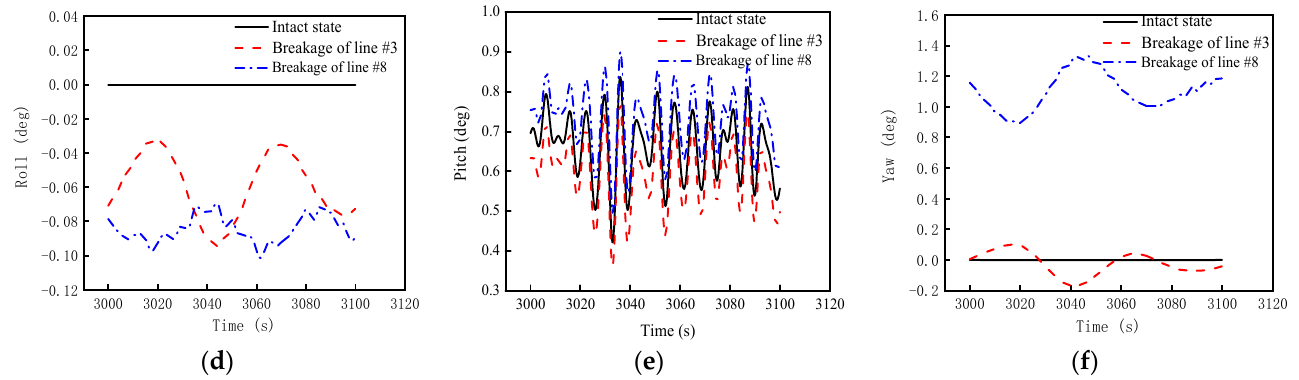
Figure 19. Motion response under different ECs for barge-type FOWT-AC: ( a ) Time histories of surge; ( b ) Time histories of sway; ( c ) Time histories of heave; ( d ) Time histories of roll; ( e ) Time histories of pitch; ( f ) Time histories of yaw.